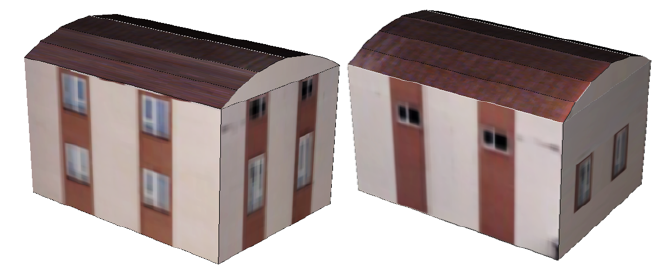
Figure 3. A building model with symmetries. Using a uniform sampling strategy will prevent ICP from recovering a rotation by 180 ◦